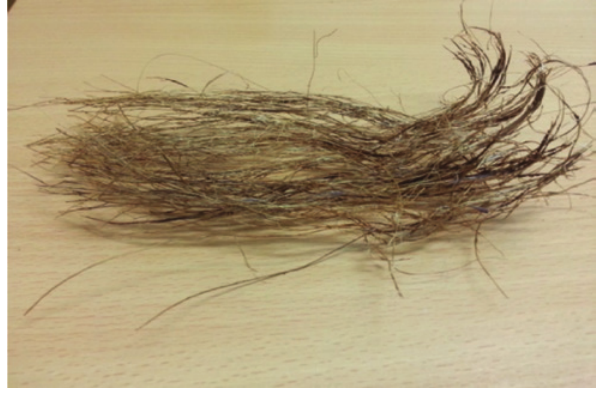
Figure 1: Extracted date palm fibers after cleaning.